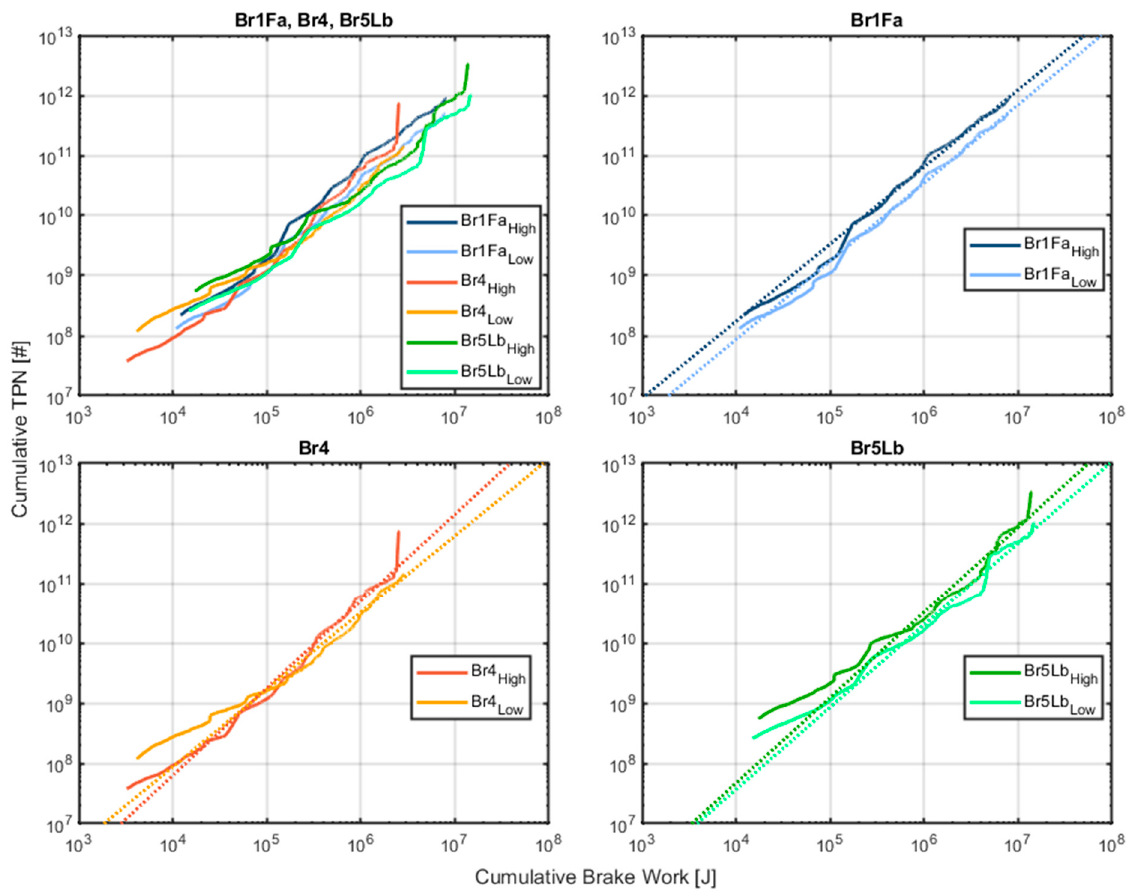
Figure 9. Log–log graph for the cumulative TPN as a function of cumulative brake work for six tests from three different brakes. Dashed lines indicate a power law regression of the data, using a 120 s sliding window (moving average). “High” refers to the highest TPN and “Low” refers to the lowest TPN values measured per